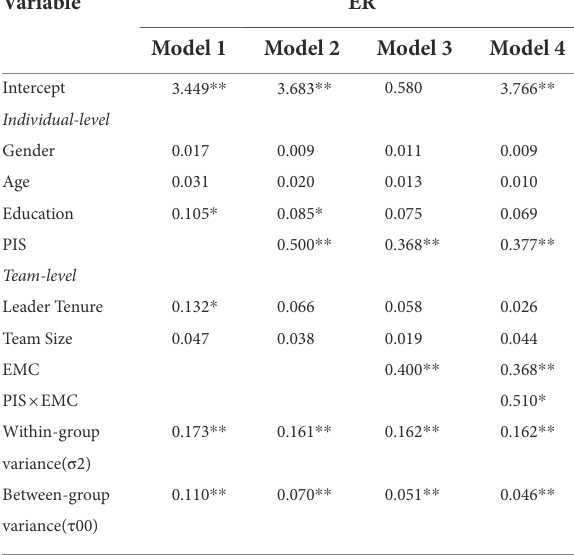
TABLE 2 Means, standard deviations, and correlations among variables.